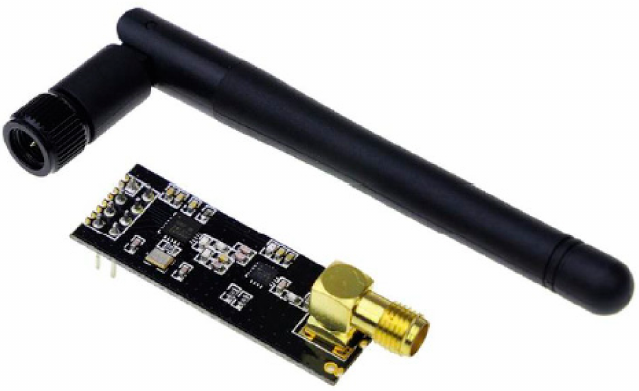
Figure 4. Long-range NRF transceiver module.